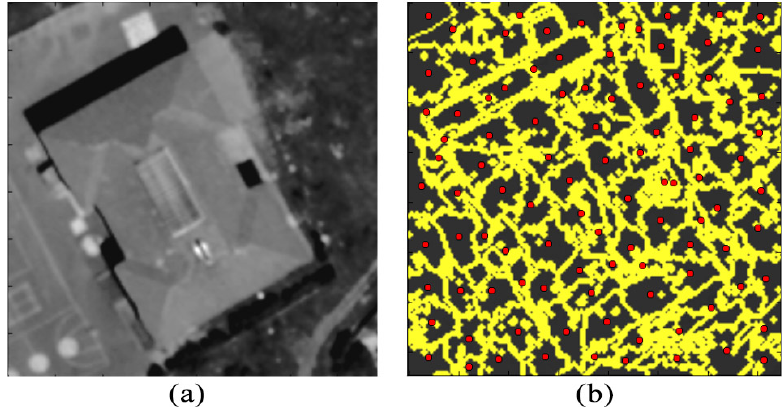
Figure 3. A building in a PAN image ( a ), and corresponding superpixels generated using a Laplacian constraint ( b ). Red dots are superpixel centers. Laplacian constraint in the formation of superpixels makes the algorithm too sensitive to noise and color